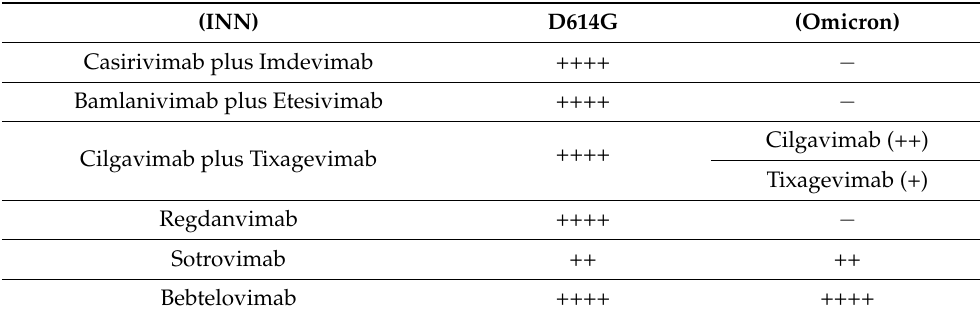
Table 2. Neutralization of SARS-CoV-2 by the nine EUA FDA and/or EMA antibodies.